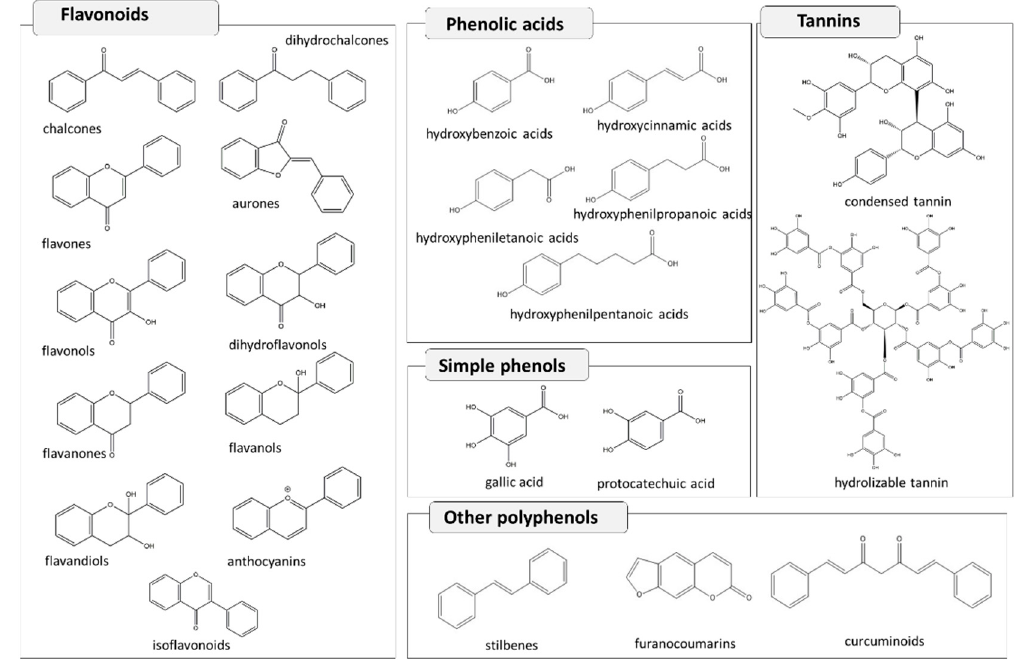
Figure 2. Examples of polyphenols, basic nucleus and classification.